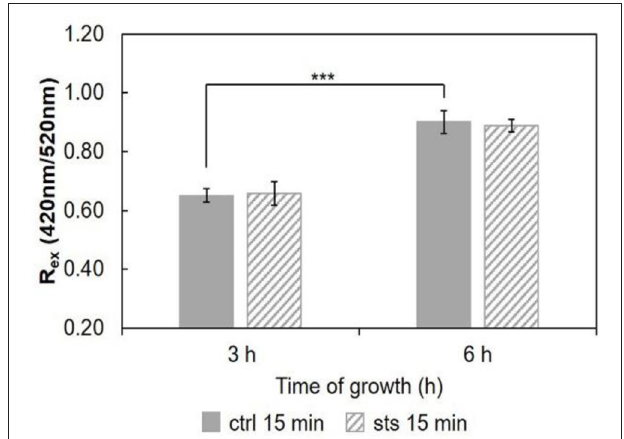
FIGURE 9 | Ratio of di-4-ANEPPS fluorescence intensity produced by excitation at 420nm to that produced by excitation at 520nm, R ex (420 nm/520nm) in cells, at 30 ◦ C. The results present the mean ± S.D. of at least three independent experiments, n ≥ 3. *** p <